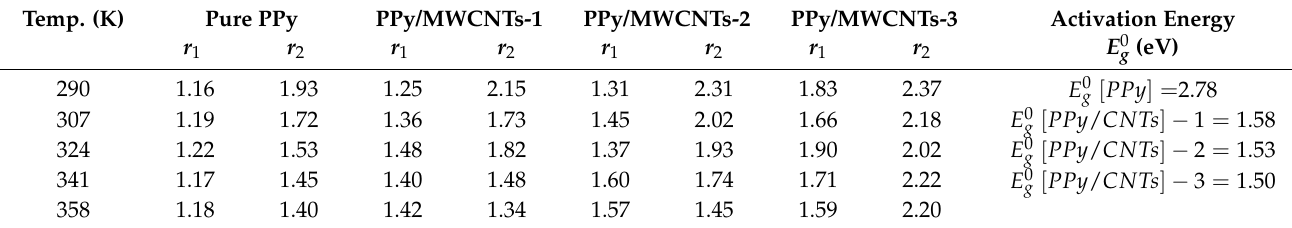
Table 5. The values of the nonlinear coefficient parameters ( r 1 and r 2 ) for Au/[PPy/MWCNTs] composites/n-Si/Al heterojunction